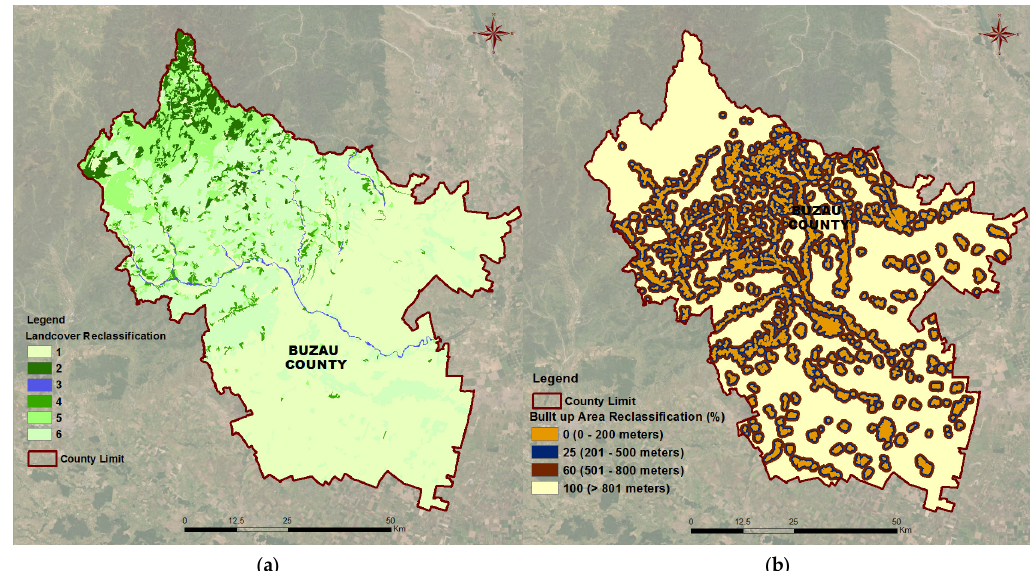
Figure 6. Results obtained by rasterization and standardization of the input datasets for the following habitat factors: ( a ) Land cover , according to CORINE 2020. The northern part of the county has forest cover and after the reclassification operation, favorable areas for the brown bear habitat and movement were identified (dark green spots and light green spots); ( b ) Built-up areas . The northern part of the county has many small, adjoined settlements. After the reclassification operation, the most favorable areas for the brown bear movement are seen on the map (the white ones, showing that the continuity of built-up areas is a major impediment in the brown bear movement) (maps created by the authors).